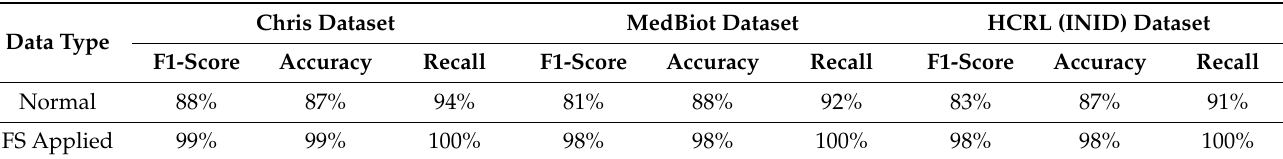
Table 4. Effect of feature selection.